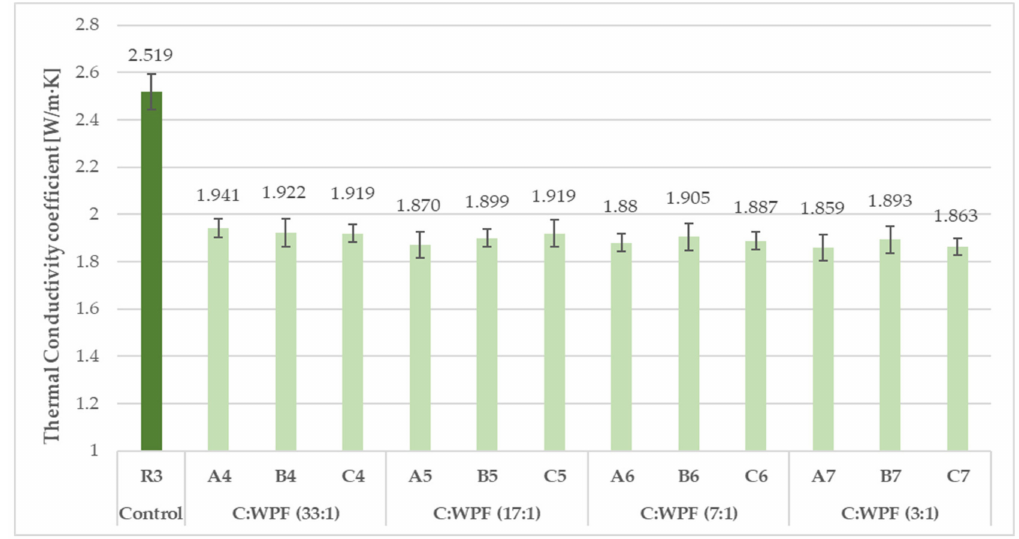
Figure 10. Thermal conductivity coefficients for 28-day hardened fiber-cement mortars (set II) with different C/WPF